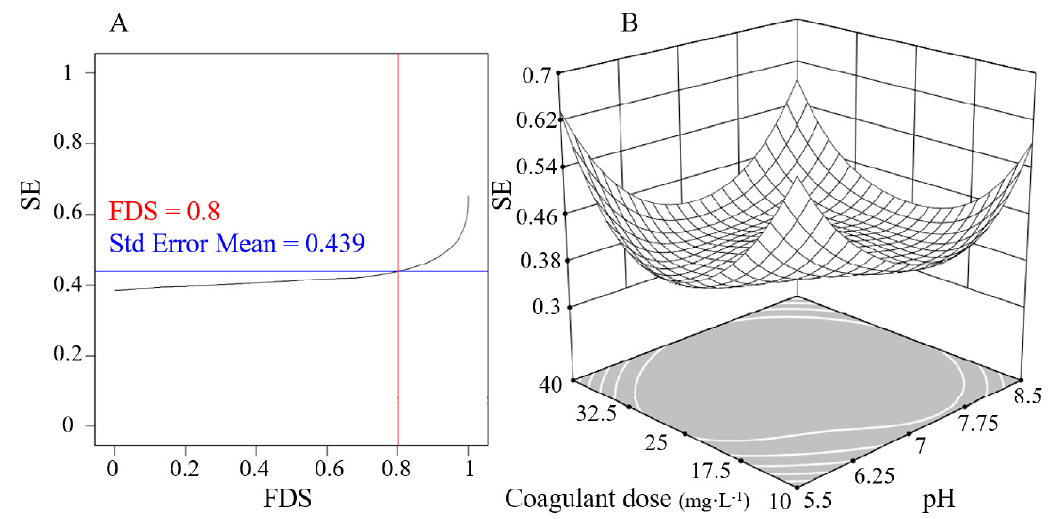
Figure 4. Model design evaluation. ( A ) Fraction of design space (FDS) graph; ( B ) Response surface standard error (SE) representation.